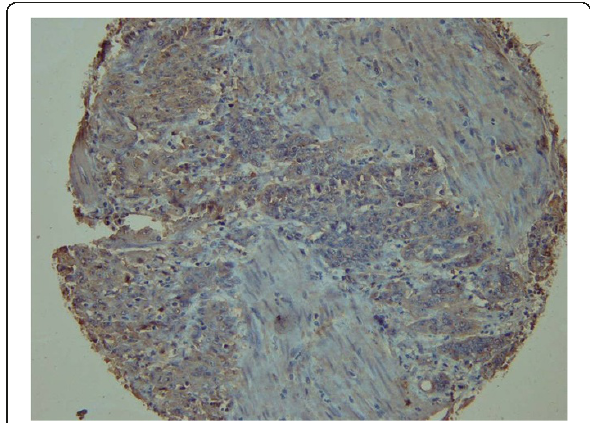
Figure 2 Immunohistochemical staining using c-MET antibody